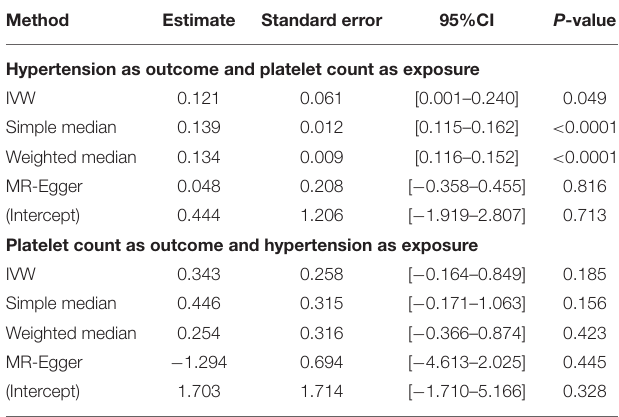
TABLE 3 | Linear regression results with platelet count as outcome, hypertension as exposure/risk factor, and with known confounders adjusted.